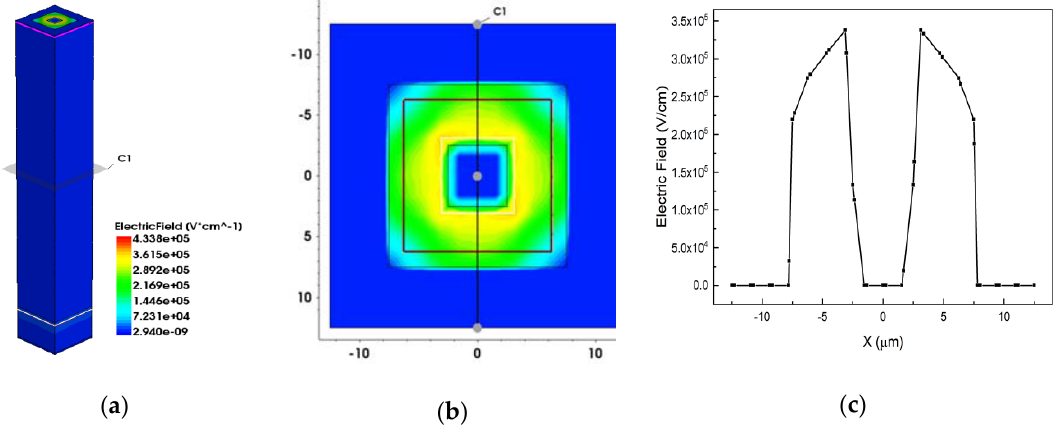
Figure 5. ( a ) The full depletion voltages; ( b ) Breakdown voltages.